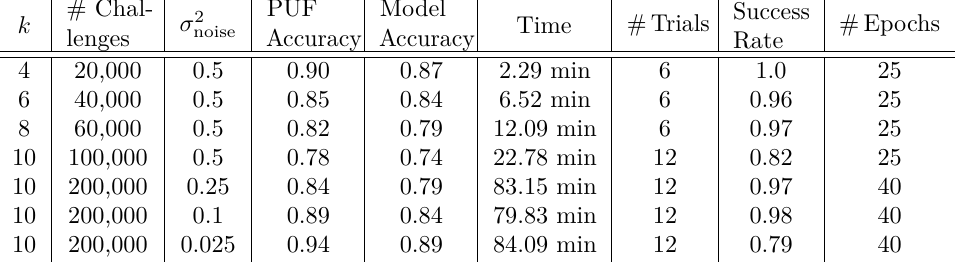
Table 2: Simulation results for the combined LR-reliability attack on XOR APUFs. For each instance size, 20 PUF instances were attacked. Note that we state the number of unique challenges. Each challenge was queried ten times to get a reliability estimate. All attacks were performed using a single